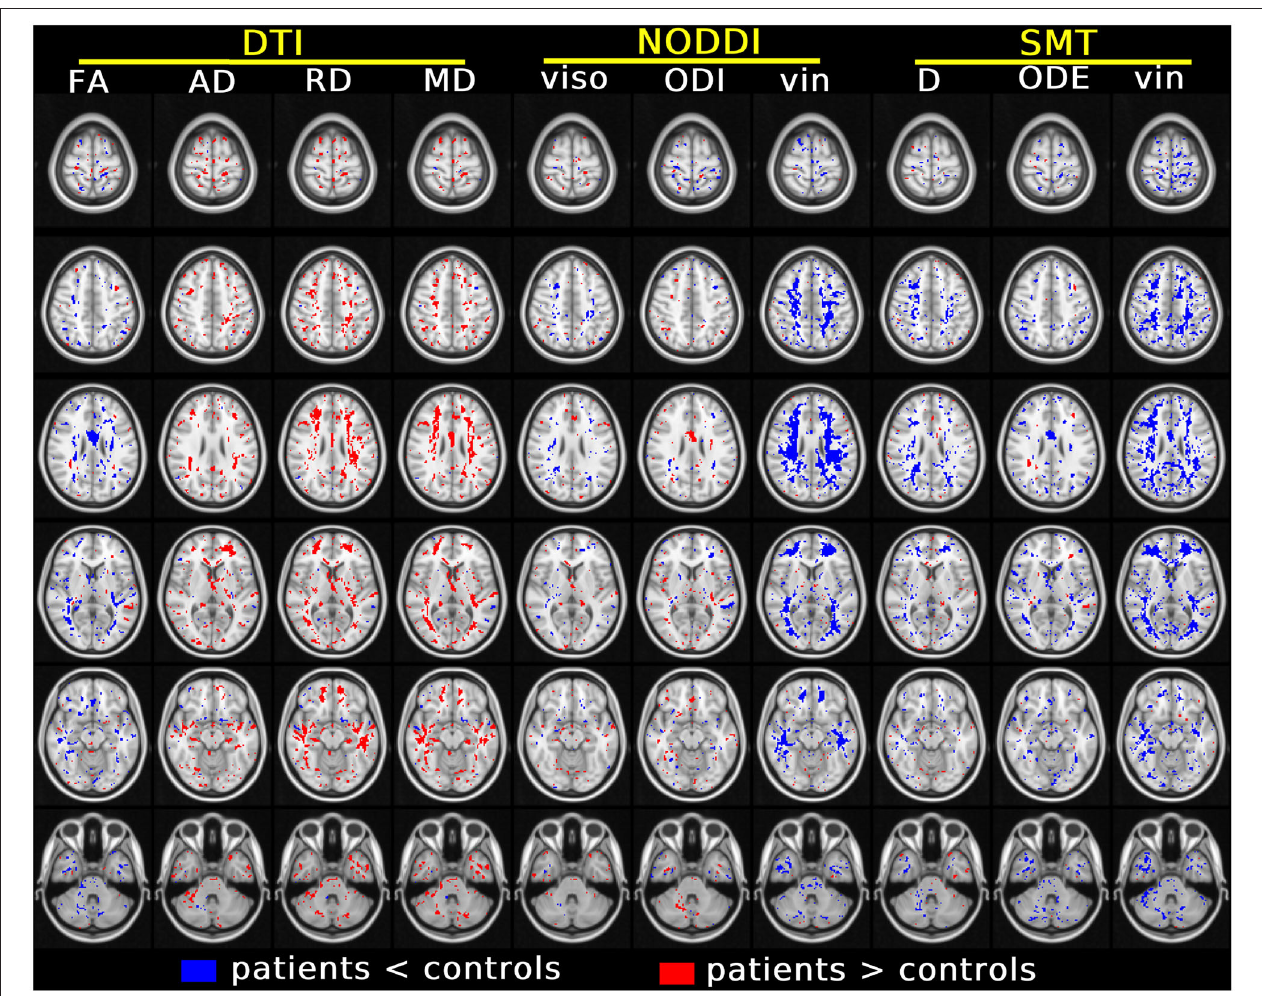
FIGURE 5 | Results of the voxel-wise group comparison performed in MNI space. The figure visualises voxels at six different axial levels where a specific MRI metric from DTI, NODDI and SMT differs significantly between patients and controls (blue/red: metric from patients smaller/larger than controls). The model used for this comparison, in the form of m = β 0 + β 1 group + β 2 age + β 3 gender with m being the generic MRI metric, adjusts for age and gender. In each MNI voxel, the model was fitted excluding measurements from focal lesions (i.e., including only normal-appearing tissues). A threshold of p < 0.05, correcting for multiple comparisons with the FSL fdr tool, was chosen for statistical significance. The figure shows voxels where β 1 is statistically different from